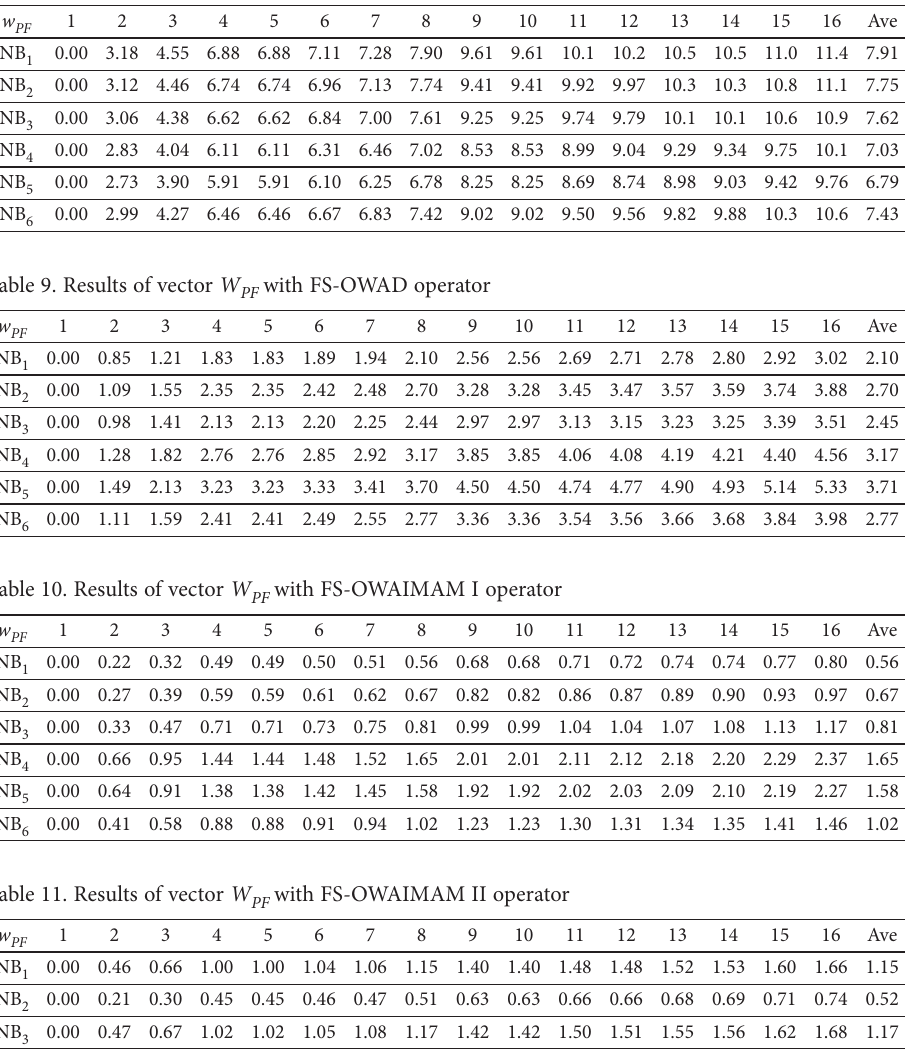
Table 8. Results of vector W